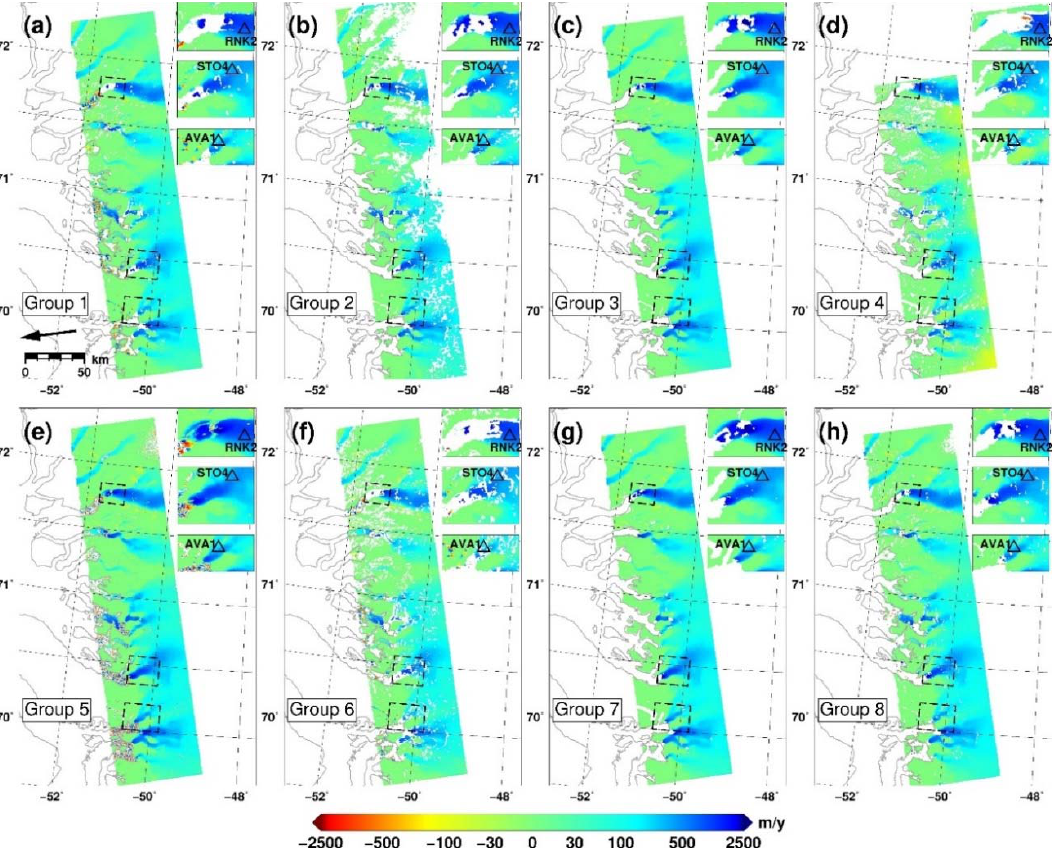
Figure 15. Task 4 LoS velocity maps provided by groups 1 to 8 ( a – h ). Positive values correspond to motion towards the radar along the LoS vector (from ground to satellite), the ground projection of which at scene center is shown by the arrow in ( a ). The insets show the GPS stations used for validation.